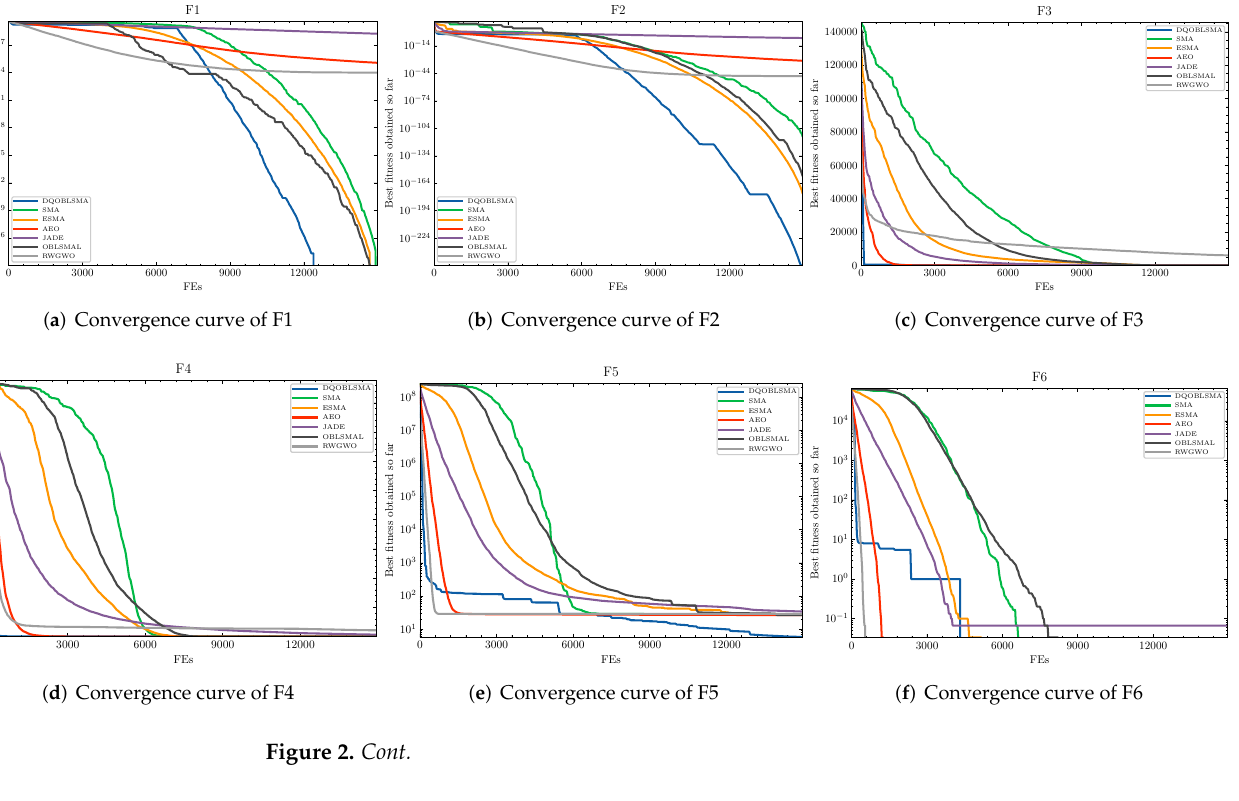
( f ) Convergence curve of F6